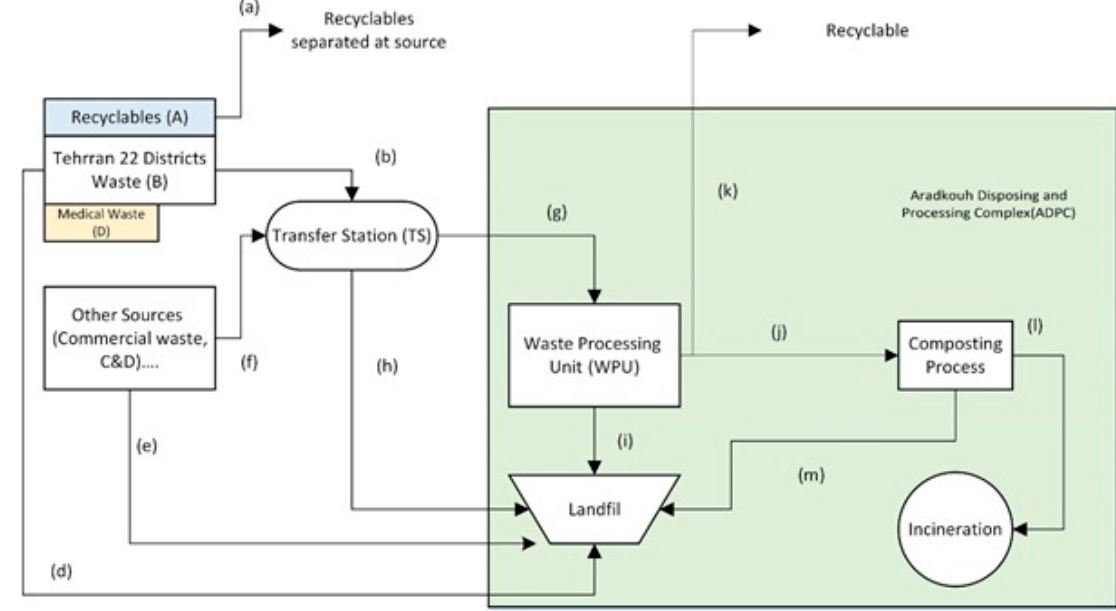
Figure 1. Waste management flow in Tehran (letters (a)–(k); Adopted from Malmir et al. [20].